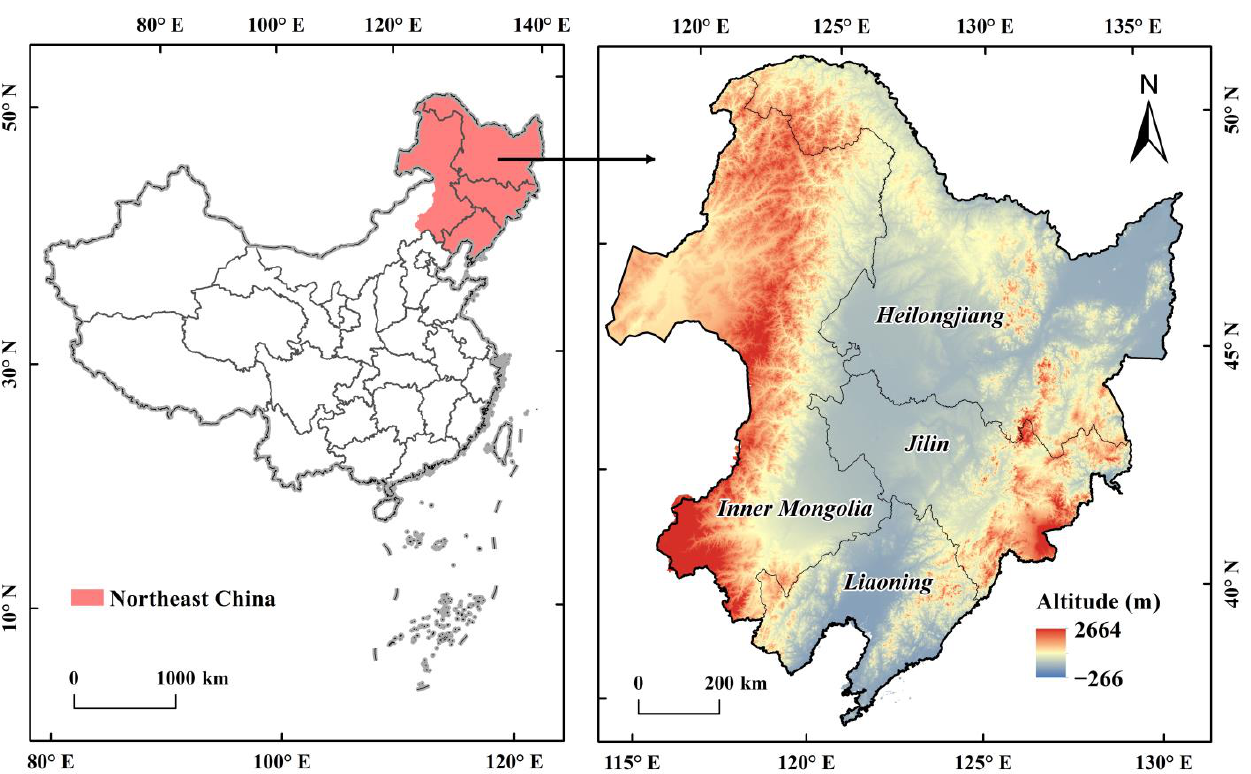
Figure 1. Location and altitude of Northeast China. The vector boundary data of China and Northeast China are from the Resource and Environmental Science and Data Center of the Chinese Academy of Sciences (www.resdc.cn, accessed on 20 November 2021), and the altitude was obtained from the SRTM DEM data (https://srtm.csi.cgiar.org/, accessed on 20 November 2021).